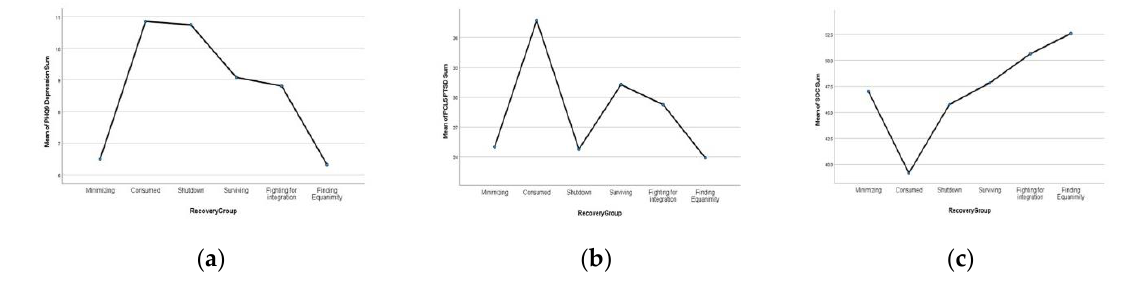
Figure 1. Recovery group ’ s means: ( a ) depression; ( b ) PTSD; ( c ) SOC